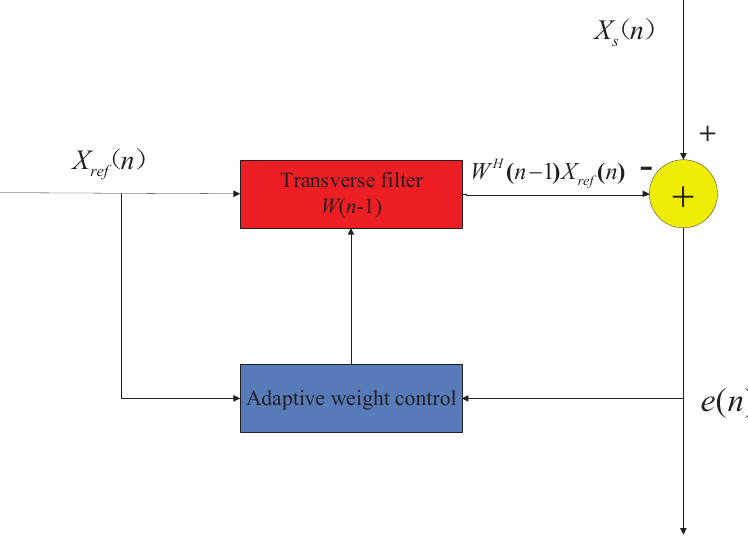
Figure 3. The suppression methods of DPI and MPI.